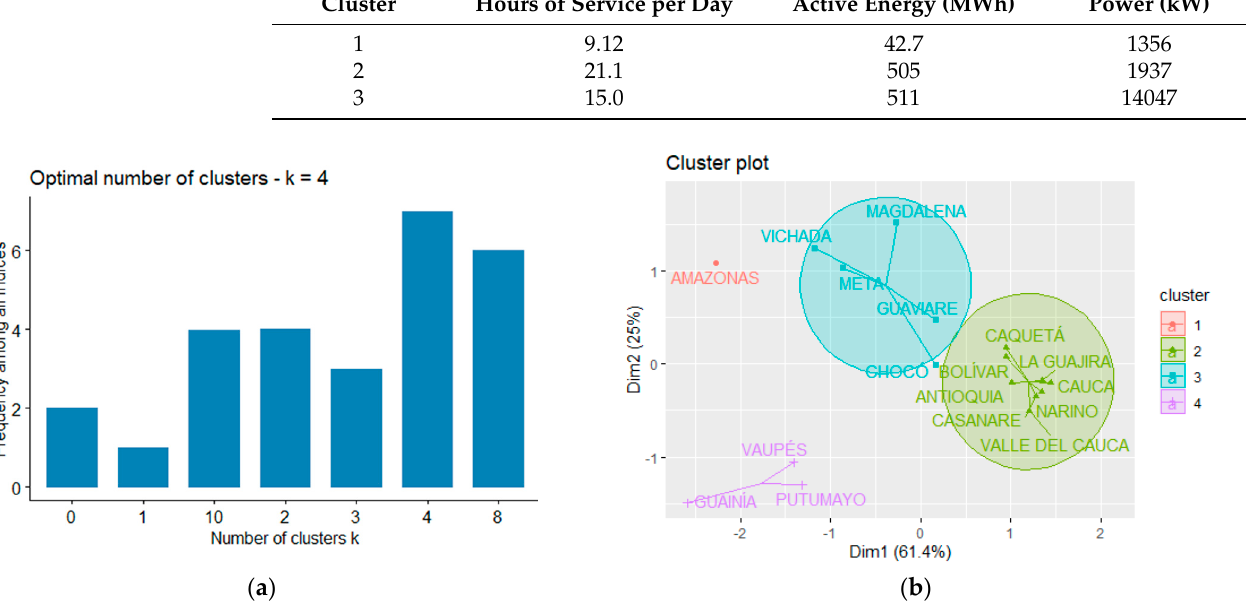
Figure 4. ( a ) Optimal number of clusters; ( b ) clusters by K-medoids algorithm (shire counties, active energy, operating hours, and power). Table 4. Representative means of shire counties clusters by K-medoids.